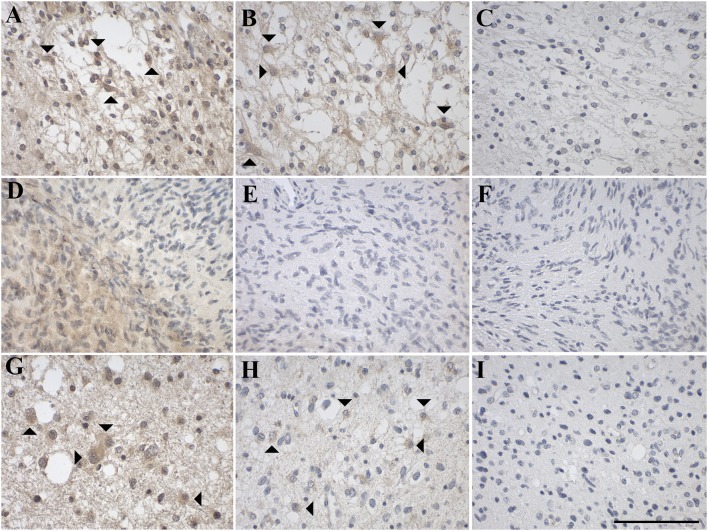
Representative images of immunohistochemical staining of low-grade astrocytic tumors with (A–C) pilocytic astrocytoma (WHO grade I; case 1), (D–F) diffuse astrocytoma (WHO grade II; case 8), and (G–I) anaplastic astrocytoma (WHO grade III; case 12). GAL immunoreactivity is shown in (A,D,G); GAL1-R immunoreactivity in (B,E,H), and GAL3-R immunoreactivity in (C,F,I). Arrow heads indicate positive-stained glial cells. [scale bar: 100 μm].